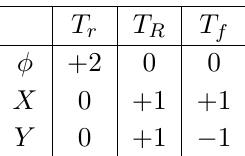
= 2 vectormultiplet and hypermultiplet under N su (2) R and (cid:13)avour symmetry (cid:8)